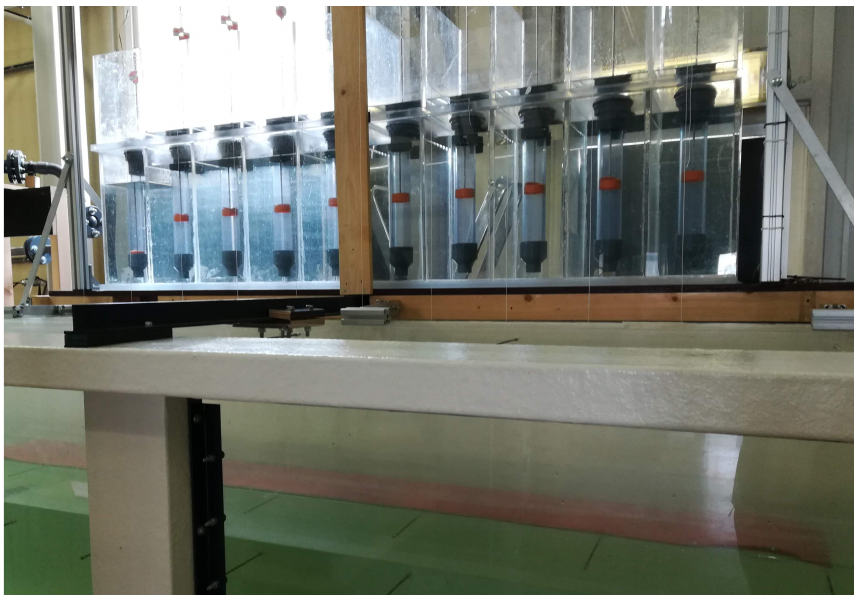
Figure 8. Laboratory model of the MP 2 PTO system, made by 10 pistons.